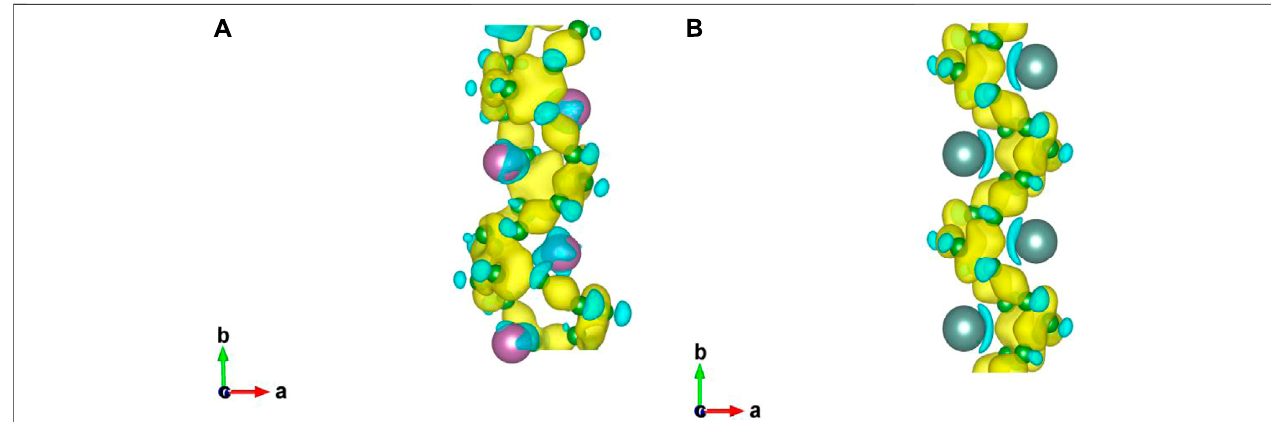
FIGURE 4 | Differential charge density diagrams of designed nanowires 1D-Sc 4 B 24 (A) and 1D-Y 2 B 12 (B) . The isosurface value was set to be 0.015 e/Bohr 3 .